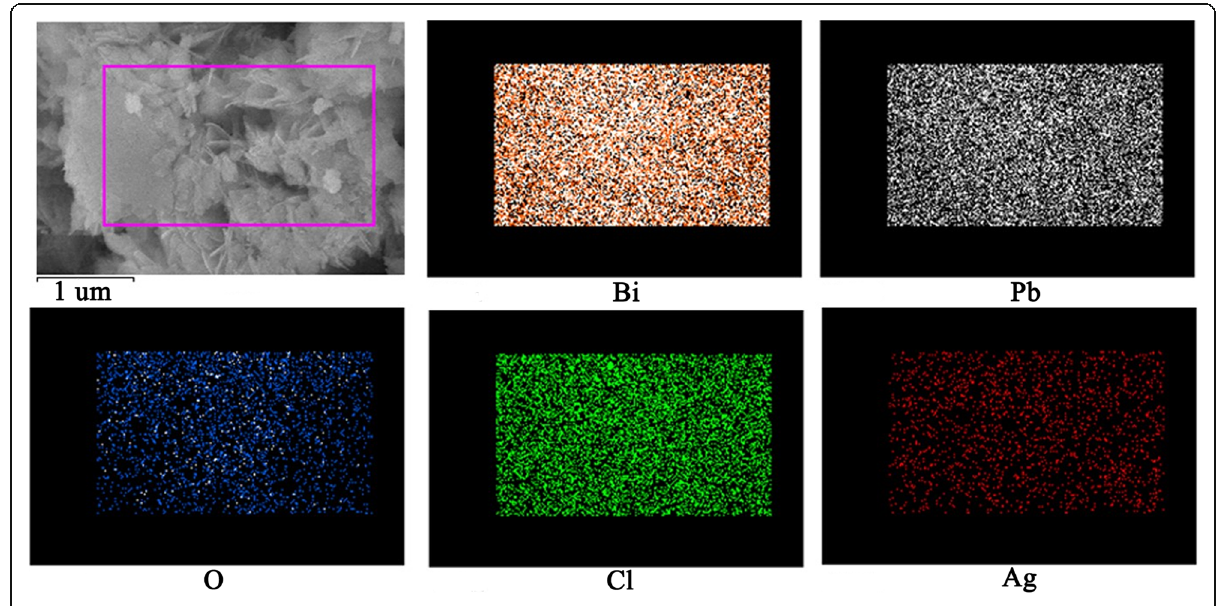
Fig. 3 EDS mapping of element of Ag/BiPbO 2 Cl